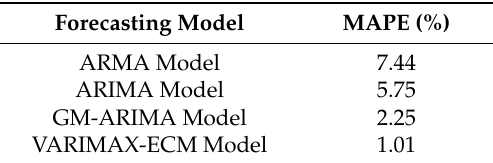
Table 4. The performance monitoring of the forecasting model.